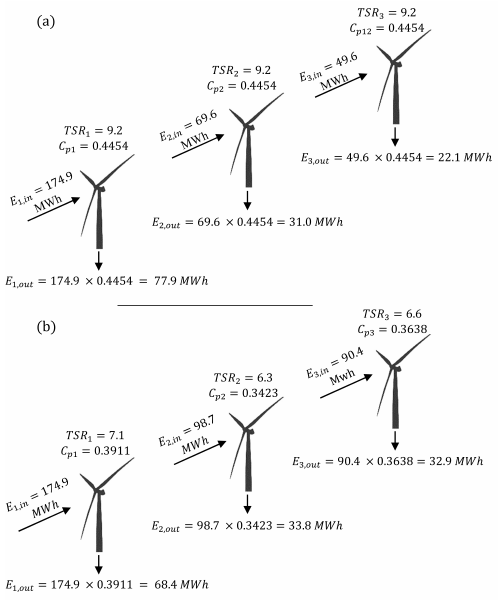
Figure 1. Solution: ( a ) optimizing TSR to maximize every individual turbine’s efficiency, leading to a total energy production of 131 MWh, ( b ) optimizing TSR to maximize the total AEP, leading to 135.1 MWh.